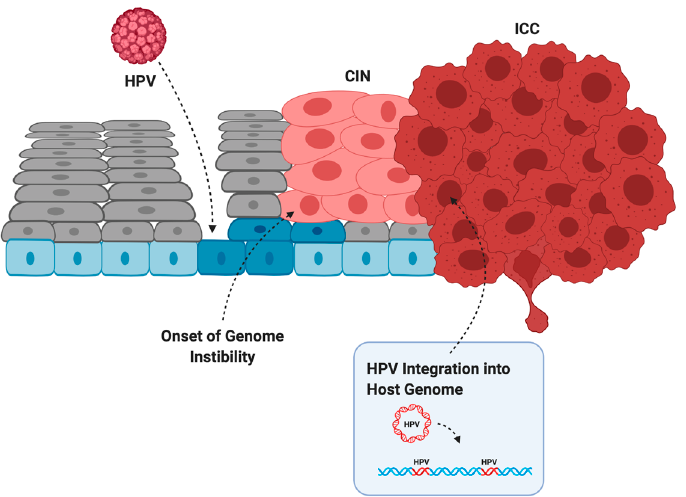
Figure 2. The evolution of HPV infection, to cervical intraepithelial neoplasia (CIN), to invasive cervical cancer (ICC). HPV infects basal cells (blue) through microabrasions in the cervical epithelium. Uncontrolled proliferation of the mid-epithelial layers allows the onset of genome instability. After acquiring additional somatic mutations and often HPV integration, the tumor breaks through the basal layer and is graded as an ICC. Created with BioRender.com.